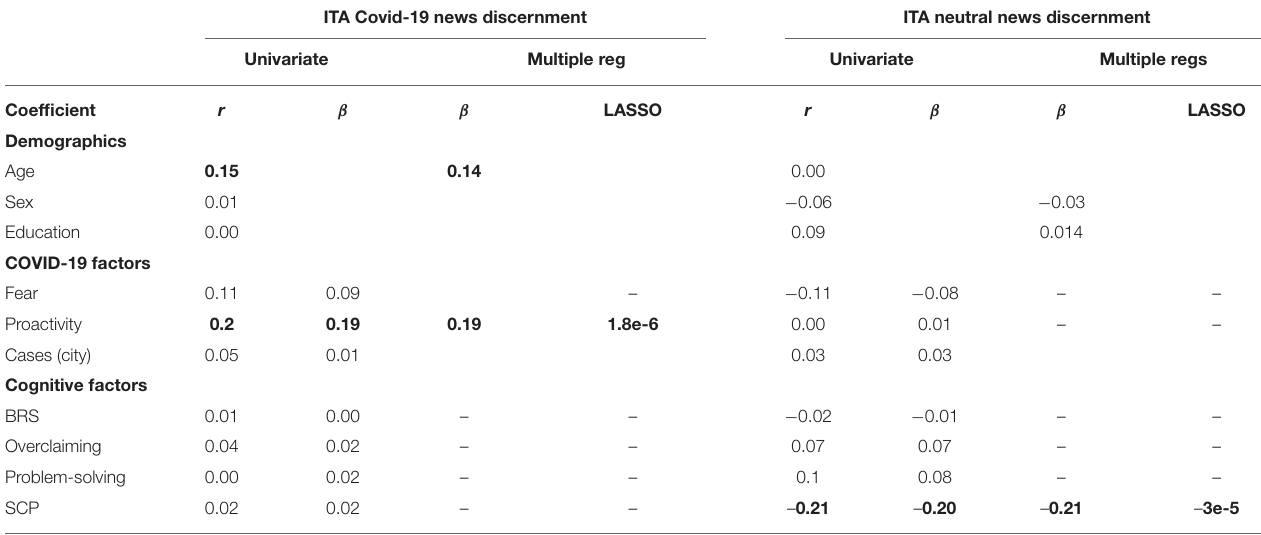
TABLE 3 | Correlation, univariate regression, multiple stepwise regression, and Lease Absolute Shrinkage and Selection Operator (LASSO) coefficients for the Italian